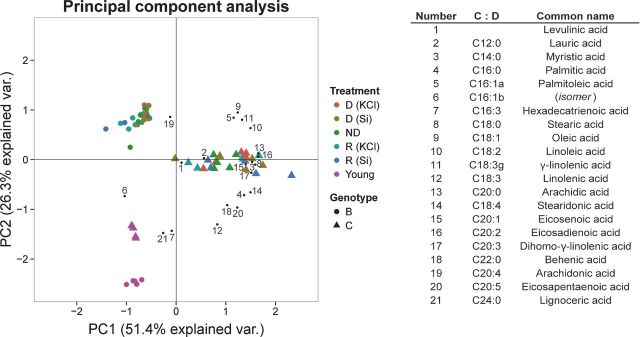
PCA ordination plot of samples from both strains and all experimental treatments based on their relative FA composition. Abbreviations: D (KCl): desiccated over KCl, D (Si): desiccated over silicagel, ND: not desiccated, R (KCl): desiccated over KCl and rehydrated, R (Si): desiccated over silicagel and rehydrated, Young: young cultures. The first two axes are shown, for additional two axes see Fig. S3, Supporting Information.